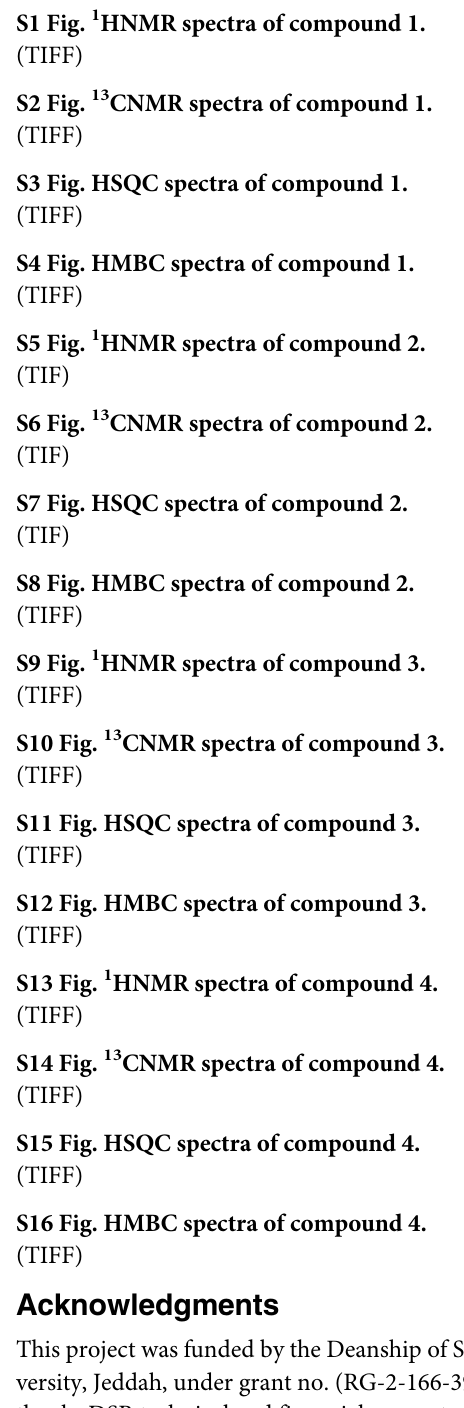
(TIFF) S2 Fig. 13 CNMR spectra of compound 1. (TIFF) S3 Fig. HSQC spectra of compound 1. (TIFF) S4 Fig. HMBC spectra of compound 1. (TIFF) S5 Fig. 1 HNMR spectra of compound 2. (TIF) S6 Fig. 13 CNMR spectra of compound 2. (TIF) S7 Fig. HSQC spectra of compound 2. (TIF) S8 Fig. HMBC spectra of compound 2. (TIFF) S9 Fig. 1 HNMR spectra of compound 3. (TIFF) S10 Fig. 13 CNMR spectra of compound 3. (TIFF) S11 Fig. HSQC spectra of compound 3. (TIFF) S12 Fig. HMBC spectra of compound 3. (TIFF) S13 Fig. 1 HNMR spectra of compound 4. (TIFF) S14 Fig. 13 CNMR spectra of compound 4. (TIFF) S15 Fig. HSQC spectra of compound 4. (TIFF) S16 Fig. HMBC spectra of compound 4.